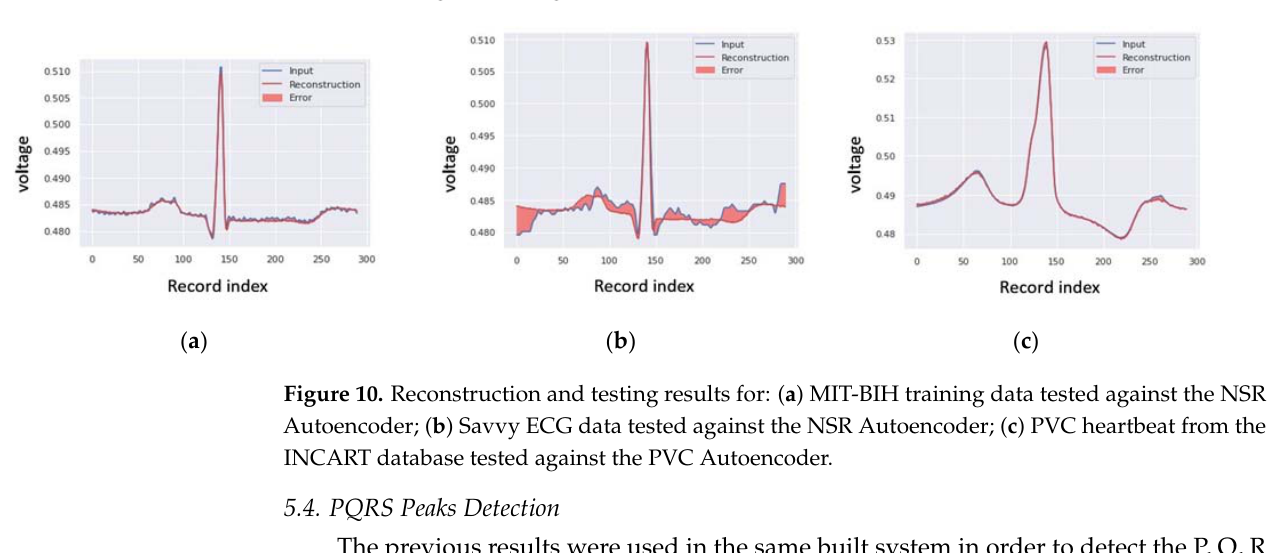
( c ) Figure 10. Reconstruction and testing results for: ( a ) MIT ‐ BIH training data tested against the NSR Autoencoder; ( b ) Savvy ECG data tested against the NSR Autoencoder; ( c ) PVC heartbeat from the INCART database tested against the PVC Autoencoder.